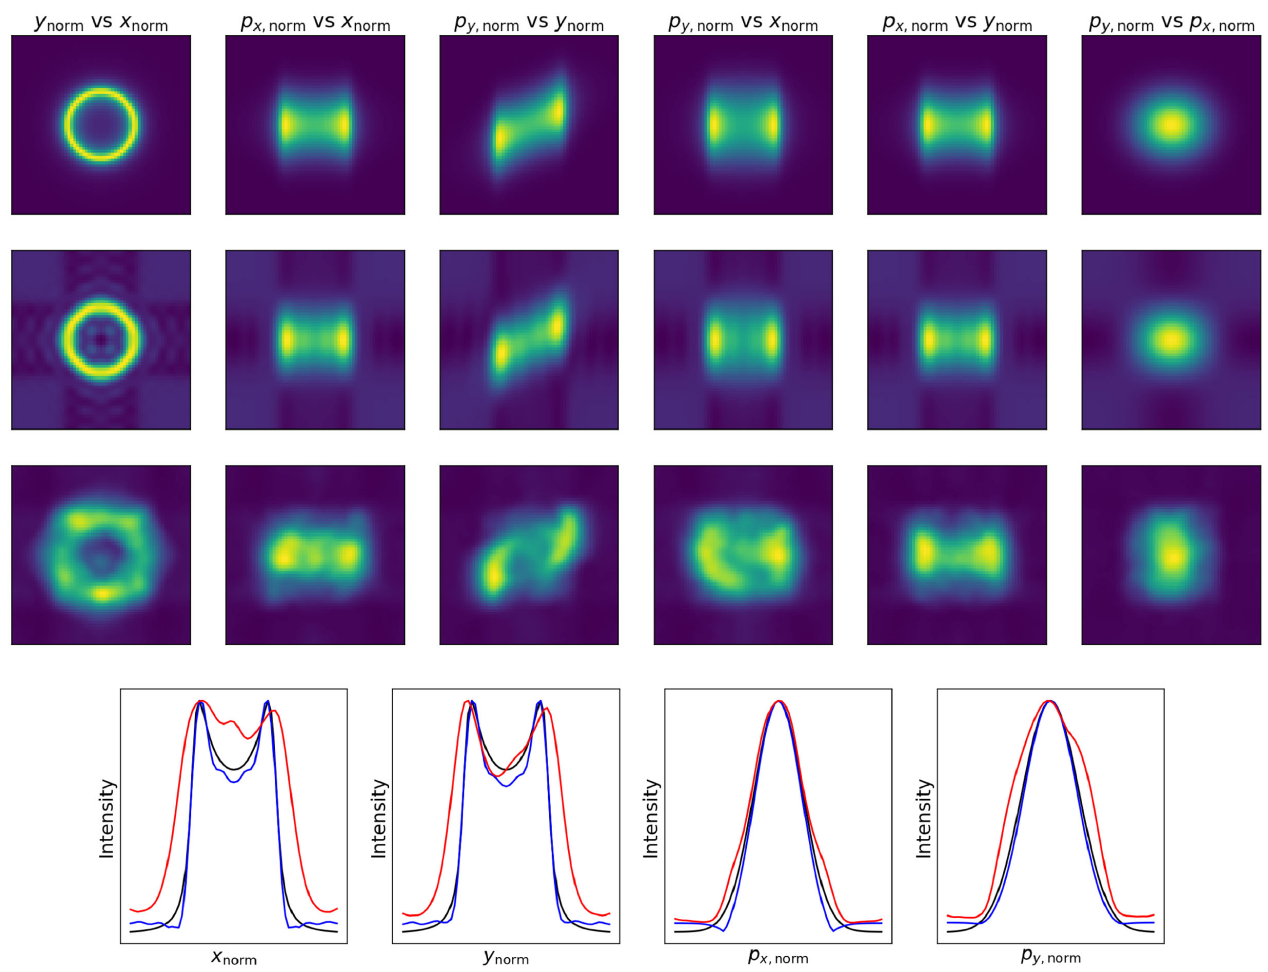
FIG. 11. Comparison of phase space projections between an original simulated phase space based on a circular “ ring ” in coordinate space (top row); the distribution reconstructed after compression and decompression using a discrete cosine transform (second row); and reconstruction, using a trained neural network, from images obtained from simulation of a quadrupole scan (third row). The bottom row shows 1D projections of the distribution onto the phase space axes, for the original distribution (black line), the compressed and decompressed distribution (blue line), and the distribution reconstructed using the neural network (red